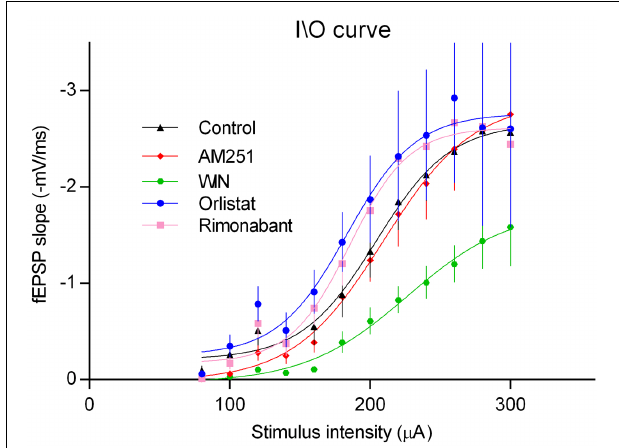
FIGURE 8 | Input/output curves where fEPSP slopes values are plotted against the stimulation intensities (80 and 300 µ A) in hippocampal slices under the drug conditions indicated. All values in the figure are represented as the mean ± SEM, n = (5–8). Statistical significance was assessed by two-way ANOVA followed by Sidak’s post hoc test, comparing multiple experimental groups; no significant differences among drug treatments were detected except for the WIN; ∗ p < 0.05 as compared with the other drugs) ( F interaction ( 44 , 360 ) = 0.5, F rowfactor ( 11 , 360 ) = 38.1, F columnfactor ( 4 , 360 ) = 14.4, t -values: control/AM251 – 0.6, control/WIN – 5.2, control/Rimonabant – 1.1, control/Orlistat –